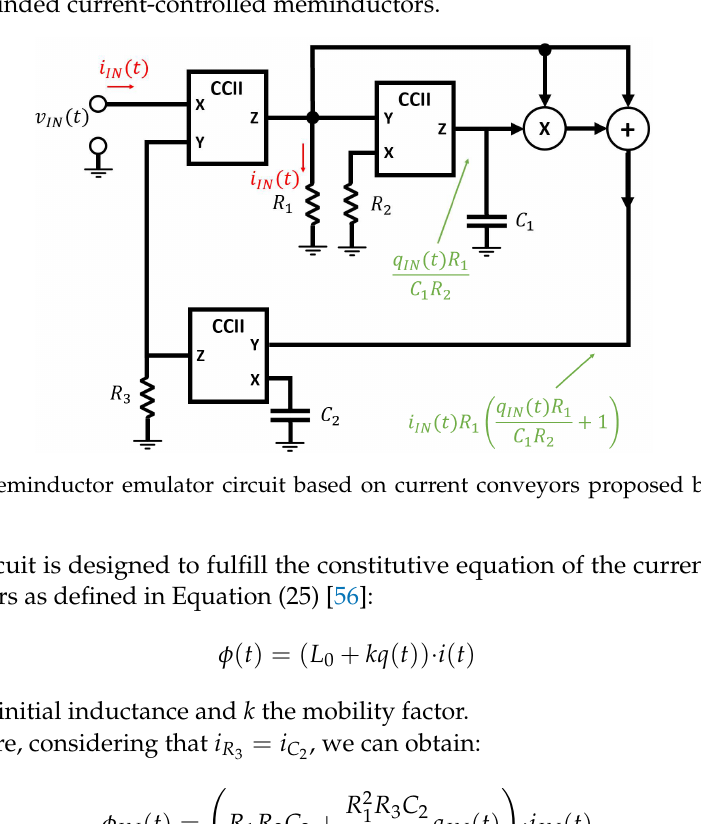
Figure 14. Floating meminductor emulator circuit based on current conveyors proposed by Liang et al . [36] .